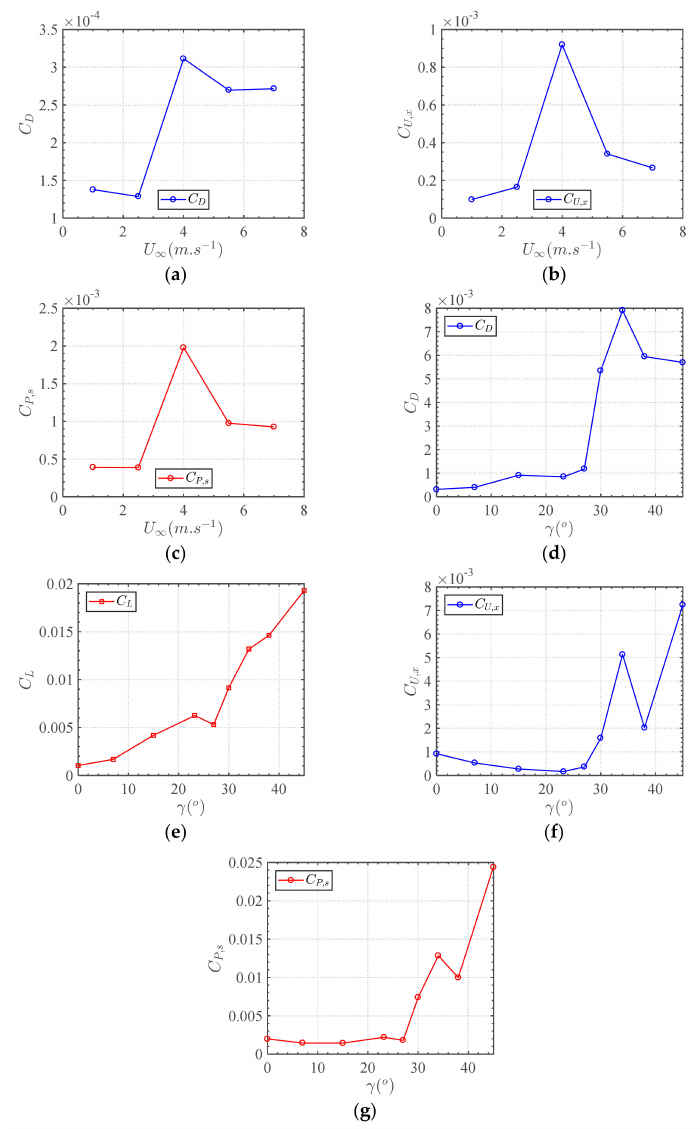
Figure A1. Evaluations of the standard deviation of the analyses conducted at aligned and yawed flows. ( a ) Evaluation of the duct drag coefficient ( C D ) with free-stream velocity ( U ∞ ) within aligned flow conditions; ( b ) Evaluation of the duct axial velocity coefficient ( C U , x ) with free-stream velocity ( U ∞ ) within aligned flow conditions; ( c ) Evaluation of the duct static pressure coefficient ( C P , s ) with free-stream velocity ( U ∞ ) within aligned flow conditions; ( d ) Evaluation of the duct drag coefficient ( C D ) with angular bearing ( γ ) within yawed flow conditions; ( e ) Evaluation of the duct lift coefficient ( C L ) with angular bearing ( γ ) within yawed flow conditions; ( f ) Evaluation of the duct axial velocity coefficient ( C U , x ) with angular bearing ( γ ) within yawed flow conditions; ( g ) Evaluation of the duct static pressure coefficient ( C P , s ) with angular bearing ( γ ) within yawed flow